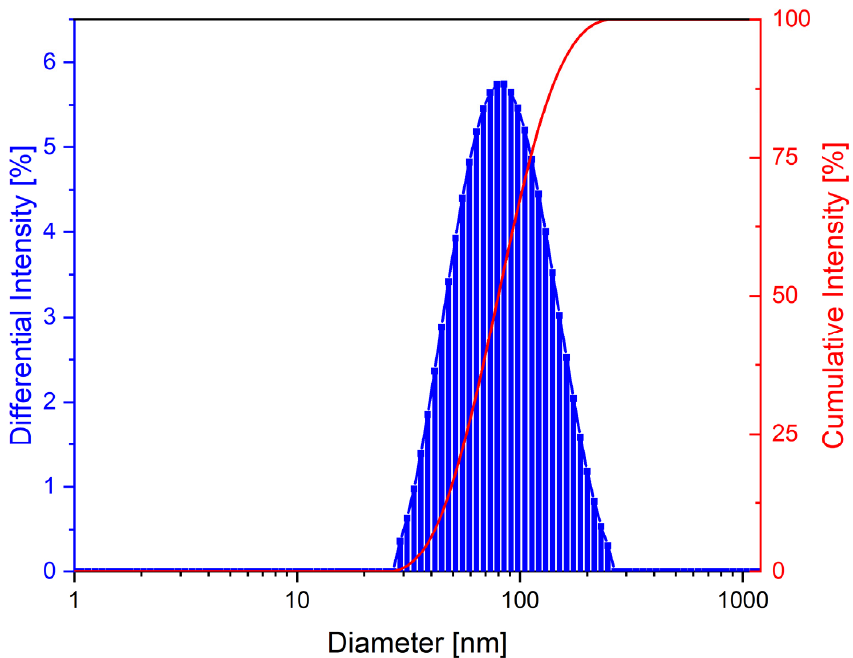
Figure 4. The intensity distribution of the particle size (DLS) of the Fe3O4@C suspension.